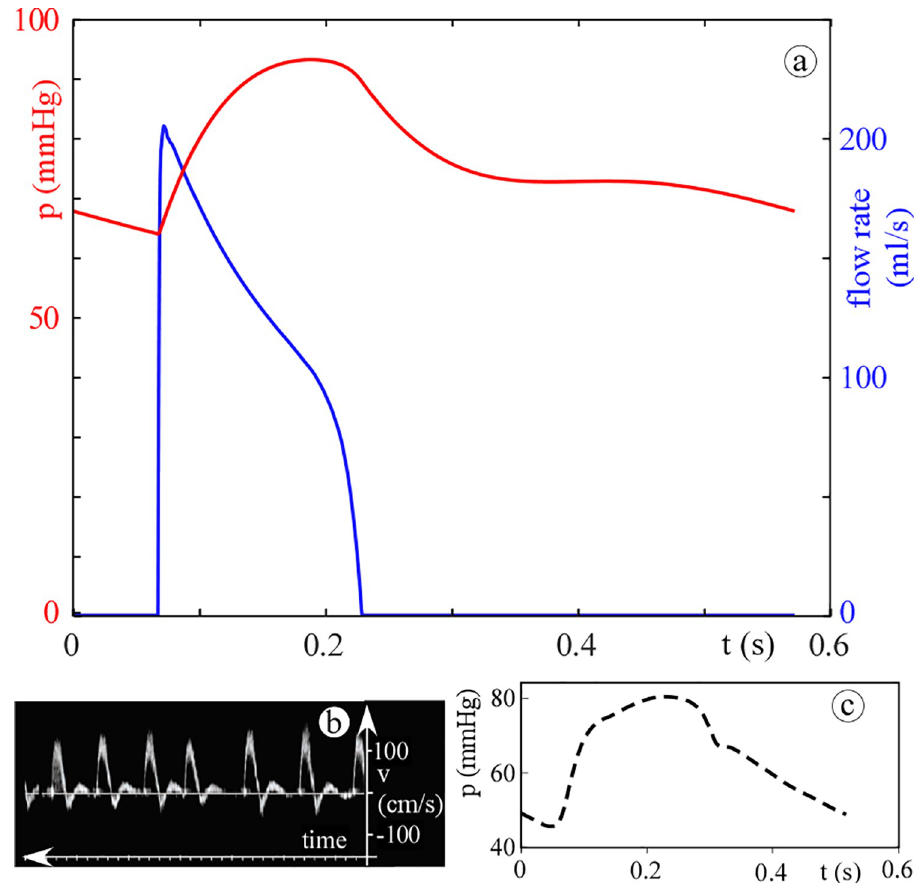
Fig 3. Panel (a): 0D model results for the physiologic case (aortic pressure, red curve; aortic flow rate, blue curve). Panels (b) and (c): published in-vivo data (aortic Doppler velocity waveform [19] and aortic pressure [20]). Note that, by assuming a constant valve area, the velocity waveform resembles the flow one except for the absolute values and the scale.